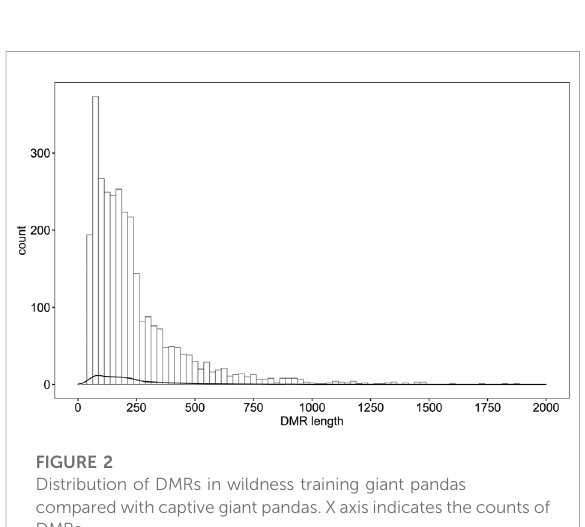
FIGURE 2 Distribution of DMRs in wildness training giant pandas compared with captive giant pandas. X axis indicates the counts of